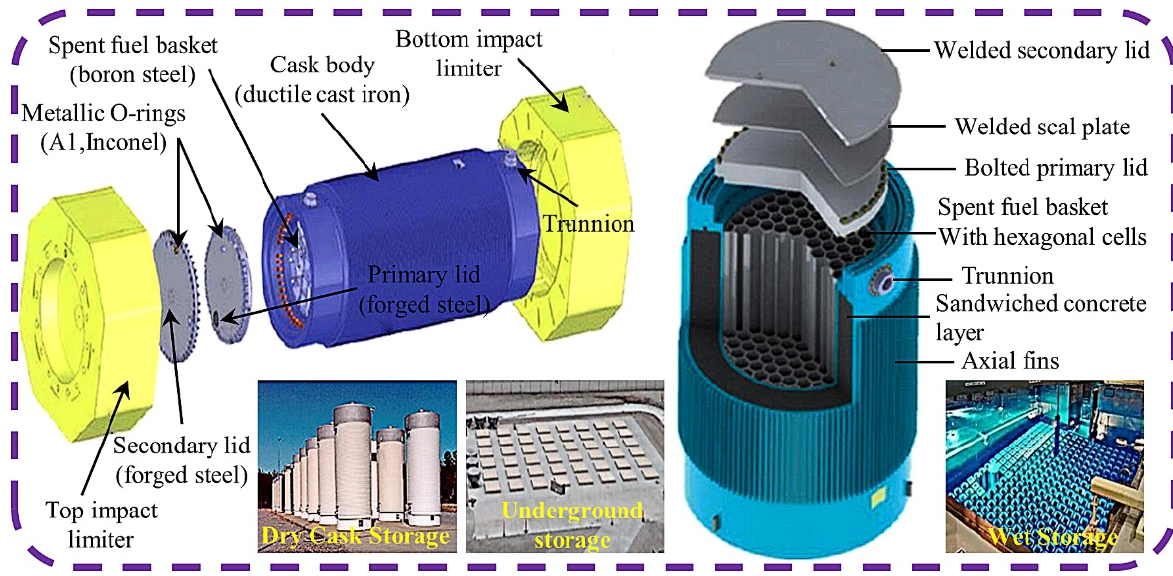
Figure 1. Typical spent fuel transport barrel and storage [2].